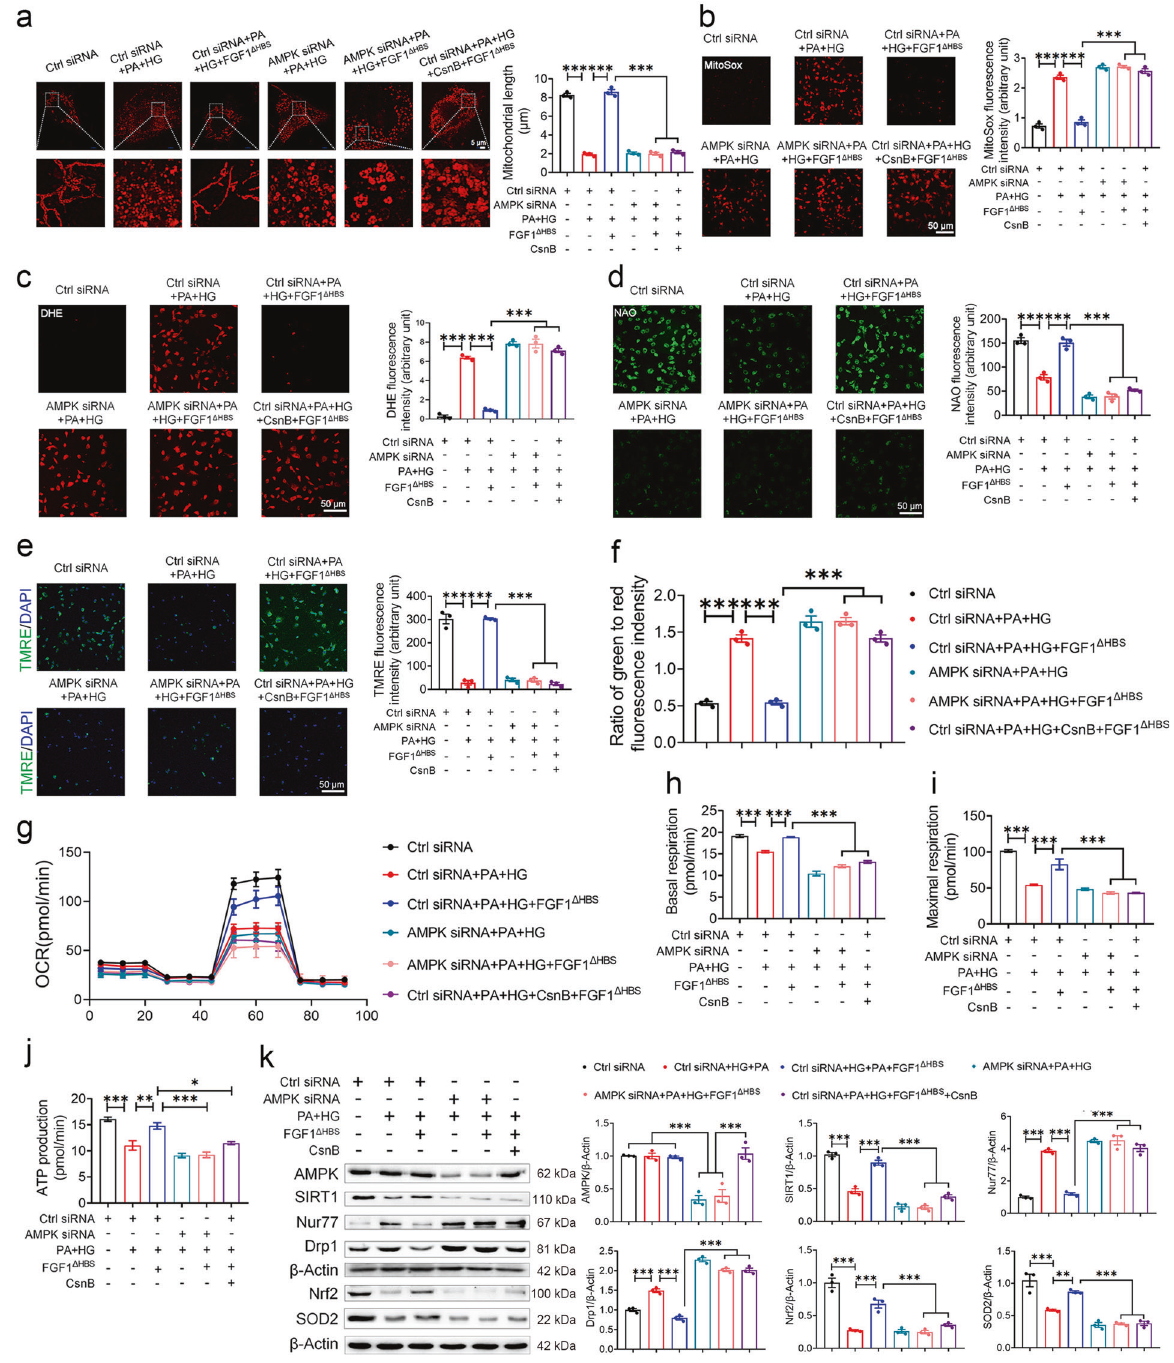
Fig. 6 FGF1 Δ HBS attenuates mitochondrial dysfunction in primary cardiomyocytes via AMPK-Nur77 pathway. a – k Primary cardiomyocytes were transfected with control or AMPK siRNA and starved for 12 h, and then cardiomyocytes were treated with palmitate (500 μ M) and high glucose (35 mM) with or without CsnB (10 μ g/mL) in FBS free medium for 1 h, followed by incubation with FGF1 Δ HBS (500 ng/mL) for additional 48 h. Mannitol + control siRNA group was an osmotic control. a Representative images of MitoTracker staining (left panel) and mitochondrial length (right panel) of primary cardiomyocytes. b – d Representative images of MitoSox ( b ), DHE ( c ), and 10-N-nonyl acridine orange (NAO) ( d ) staining and corresponding quantitative analysis of fl uorescence intensity. e Representative images of TMRE staining (left panel) and quantitative analysis (right panel) of fl uorescence intensity. f Mitochondrial membrane potential was evaluated by the ratio of JC-10 fl uorescence intensities at 529 nm (green) and 590 nm (red). g – j Mitochondrial respiratory function was assessed by OCR assay. k Western blot analysis (left panel) and densitometric quanti fi cation (right panel) of AMPK α 2, SIRT1, Nur77, Drp1, Nrf2 and SOD2 in the cardiomyocytes. n = 3 independent experiments for each group. Data were mean ± SEM; * P < 0.05, ** P < 0.01, *** P < 0.001